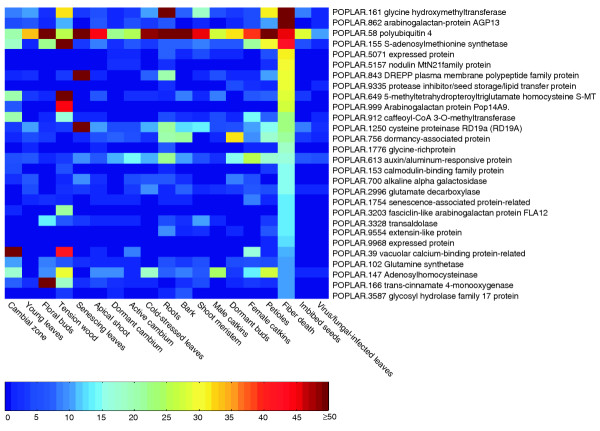
The most abundant transcripts in the fiber death library. The EST distribution in the different cDNA libraries of the POPULUSDB is shown for the 28 most abundant transcripts of the fiber death library. The transcripts are shown in descending order of EST abundance in the library. For a detailed description of the cDNA libraries, see [13]. The color code at the bottom of the figure indicates the number of ESTs in each library for each transcript.